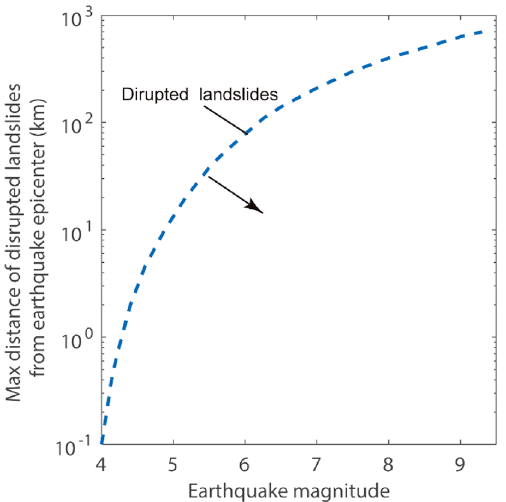
Figure 2. Variation in earthquake epicentral distance from disrupted landslides for earthquakes of varying magnitudes. The extent of black arrow points to is the distance range of disrupted landslides caused by the